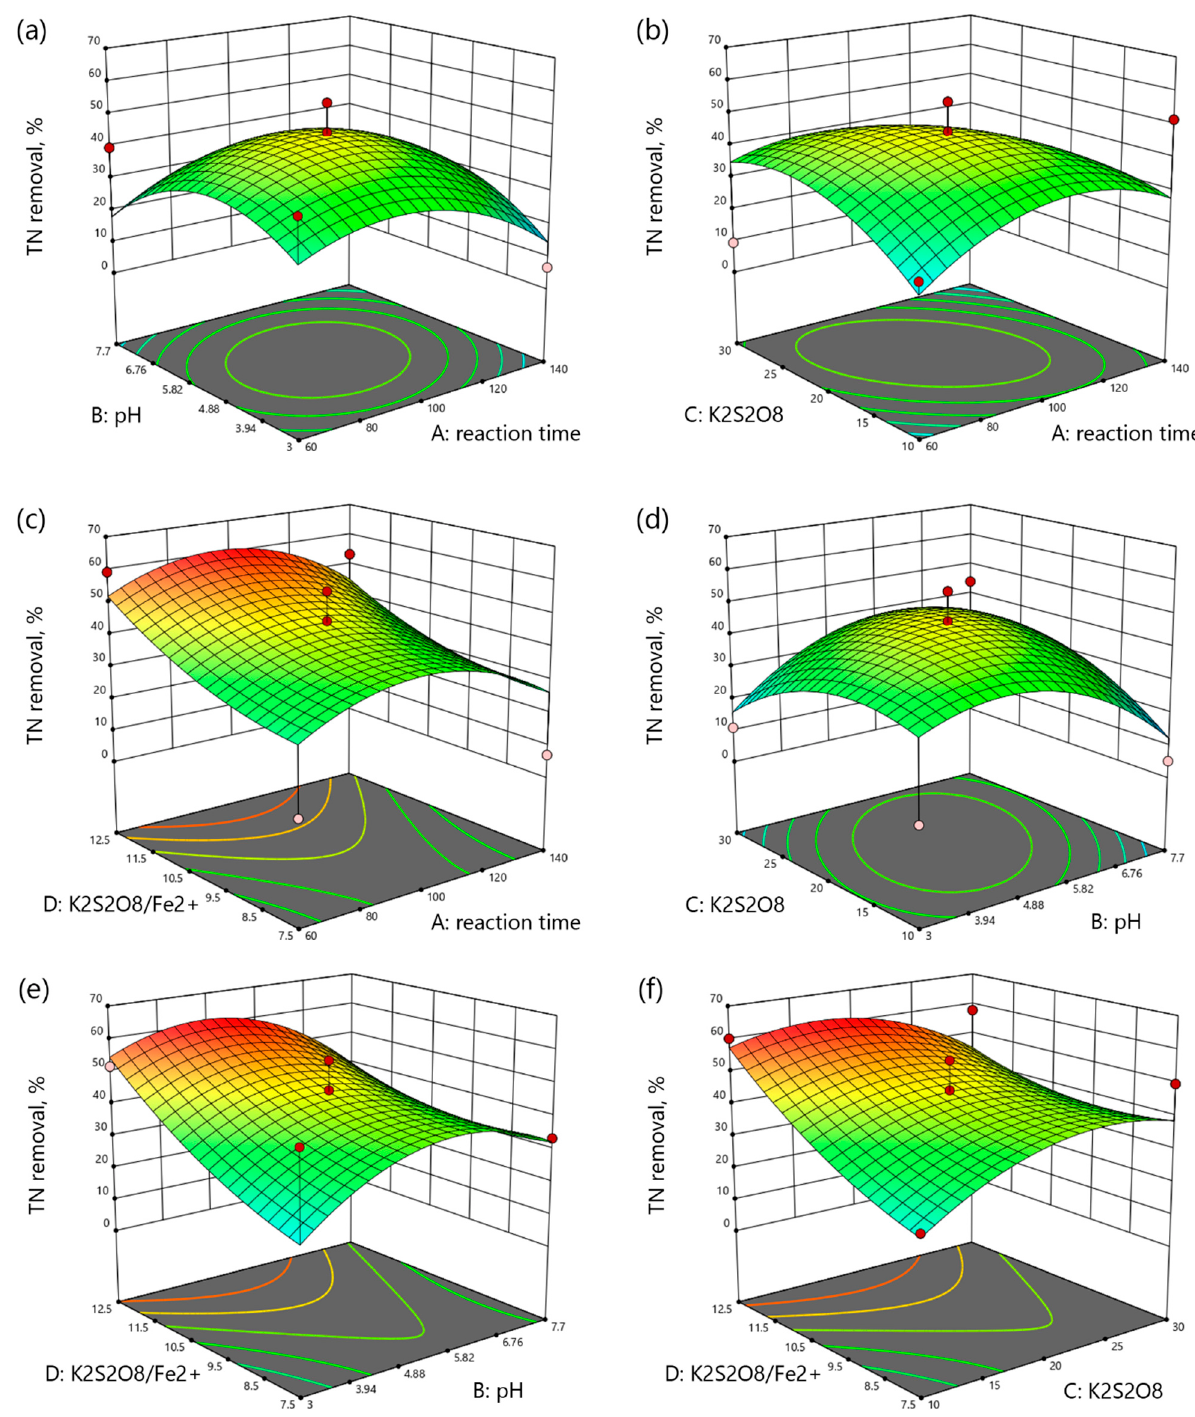
Figure 5. 3D plots of TN removal as a function: ( a ) reaction time (min) and pH, ( b ) reaction time (min) and K 2 S 2 O 8 concentration (mM), ( c ) reaction time and K 2 S 2 O 8 /Fe 2+ molar ratio, ( d ) pH and K 2 S 2 O 8 concentration (mM), ( e ) pH and K 2 S 2 O 8 /Fe 2+ molar ratio, ( f ) K 2 S 2 O 8 concentration (mM) and K 2 S 2 O 8 /Fe 2+ molar ratio.